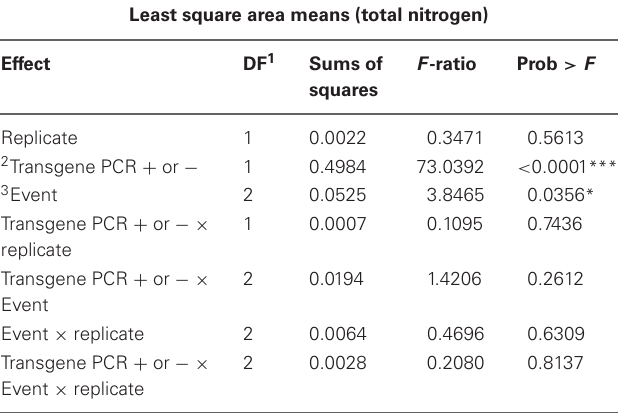
Table 4 | ANOVA for the least square means for percentage total nitrogen in transformed maize seeds, positive or negative for the soybean ferritin